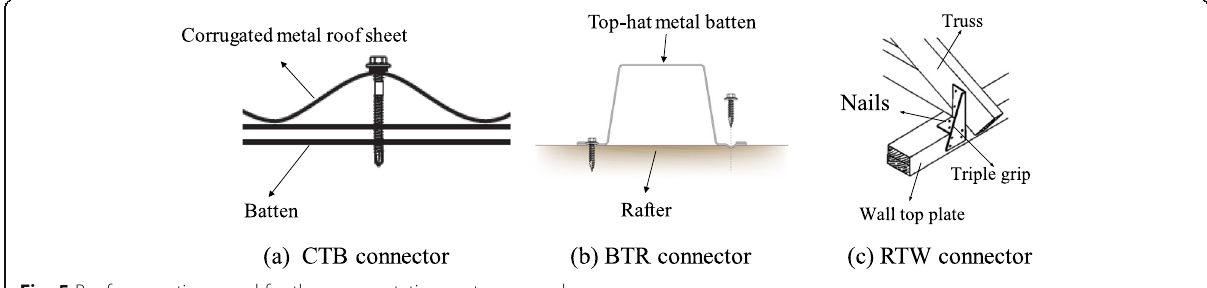
Fig. 5 Roof connections used for the representative contemporary